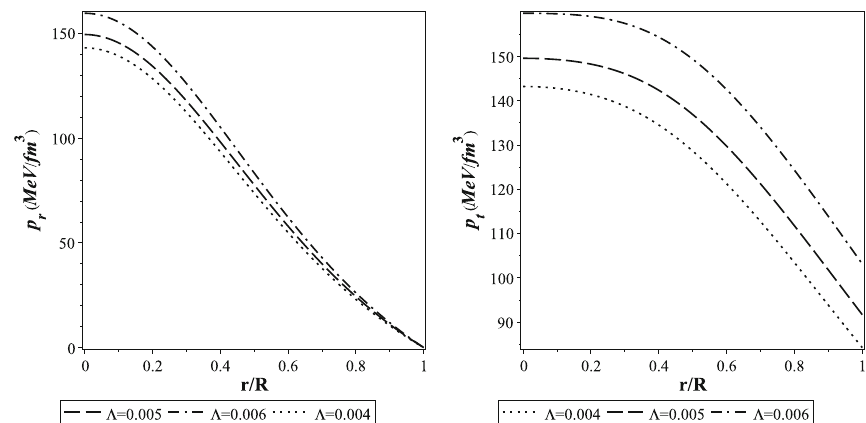
Fig. 2 Behavior of the radial pressure p r (left panel) and the tangential pressure p t (right panel) as a function of the fractional radial distance for the strange star candidate LMC X − 4 are